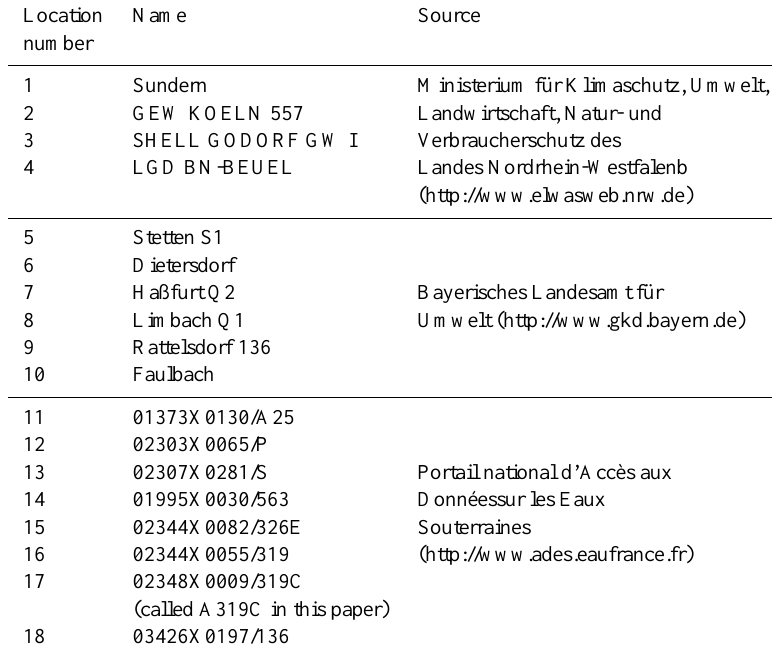
Table A1. Names of the well locations used in this